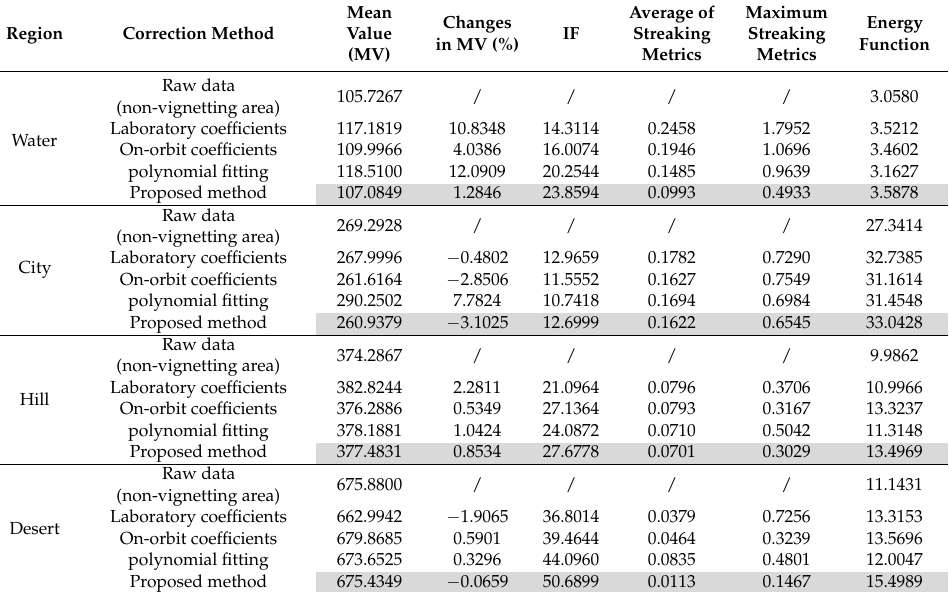
Table 3. Comparison of quantitative values for the images. IF, improvement